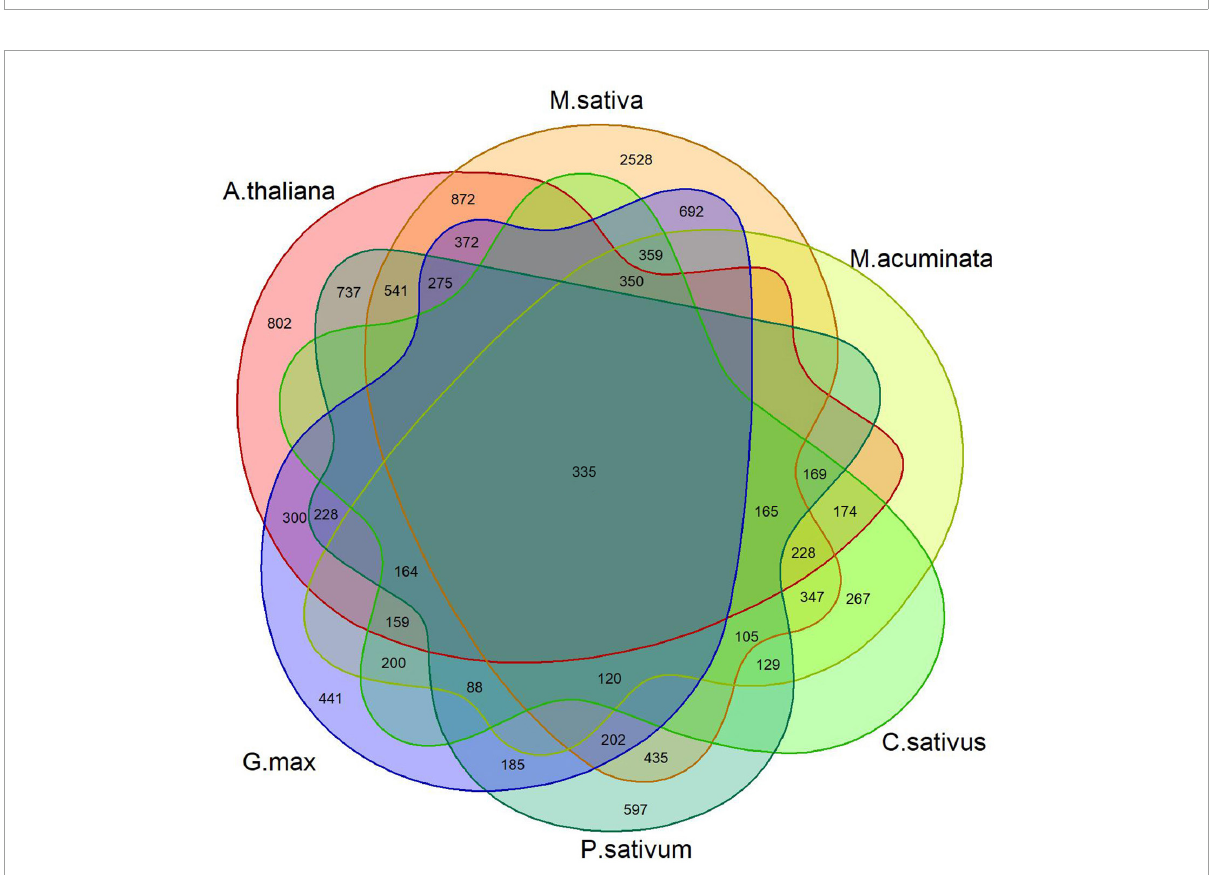
FIGURE2 Overlap of DEGs in the F. oxysporum expression profile across six infected plant host